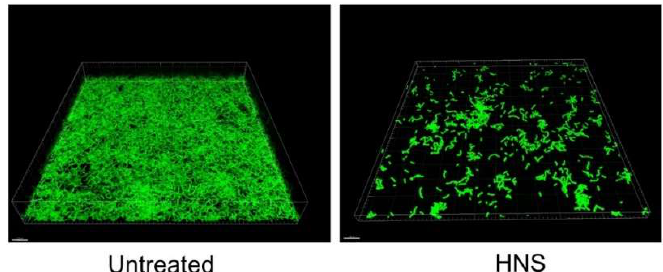
Figure 3. Inhibitory effects of the HNS on the biofilm formation by S.mutans , measured by confocal laser scanning microscopy. S. mutans cells were treated with HNS (500 μg/mL) for 48 h. The biofilms formed were stained with fluorescein isothiocyanate isomer (FITC), and the three-dimensional findings were obtained from the confocal optical sections.